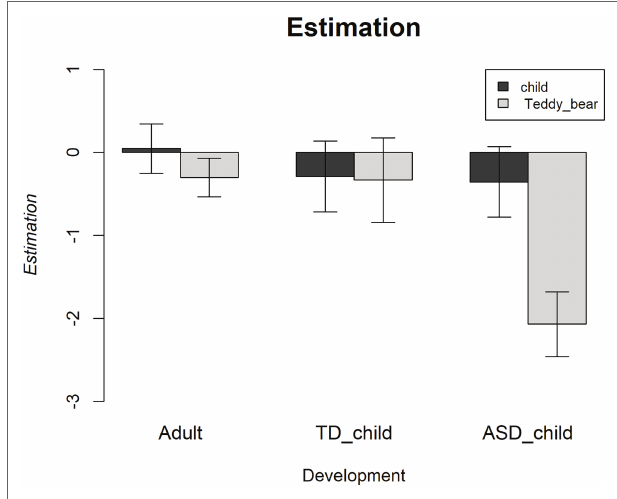
FIGURE 4 | Mean estimation of the visible sweets relative to the correct number. Zero represents a correct answer, while higher values represent an overestimation of how many sweets are visible when looking at the mirror. Error bars are ±1 SE for the